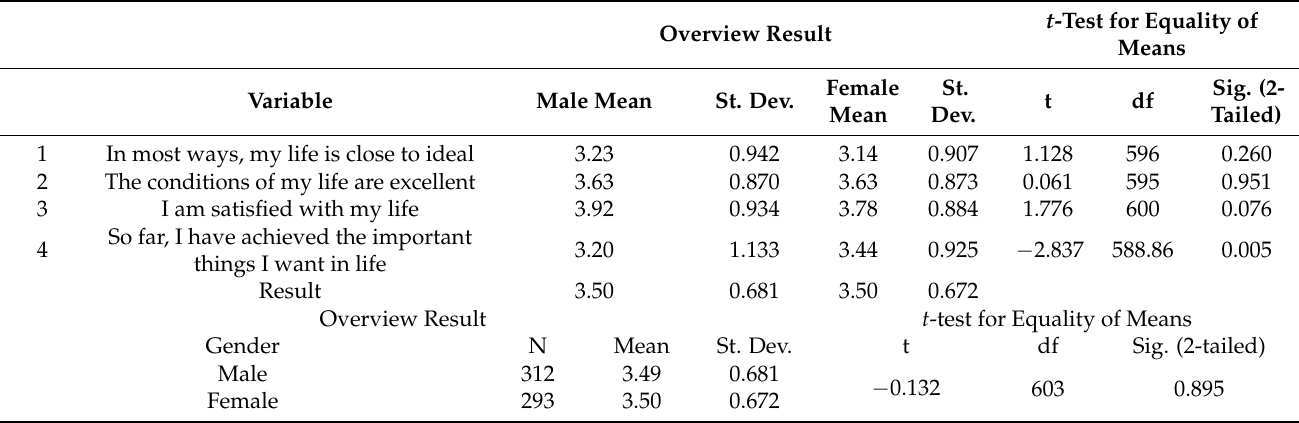
Table 4. Gender comparison: Life